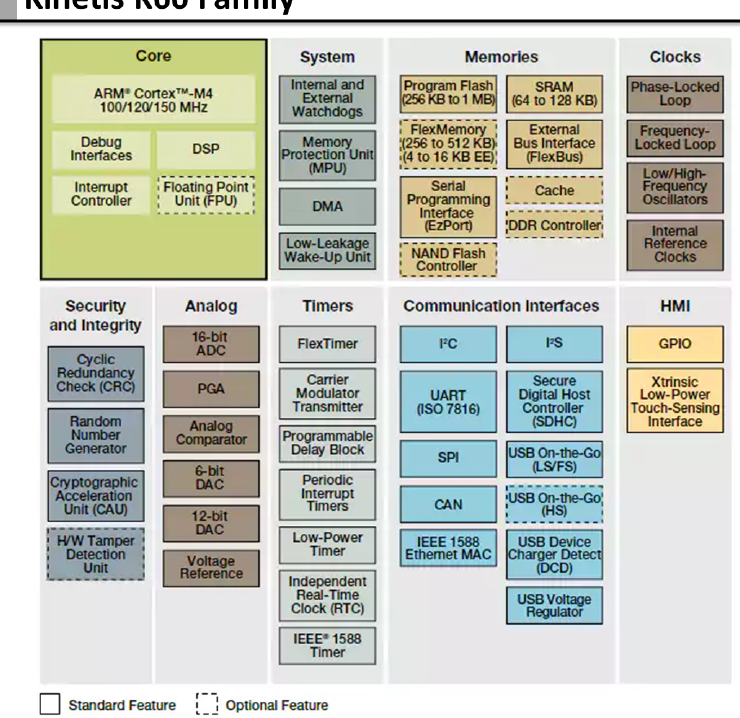
Figure 9. Architecture of K60 micro-controller used in the secondary unit of